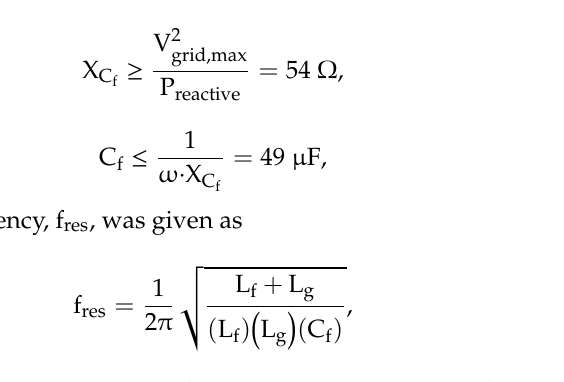
Table 2. Passive elements. Elements